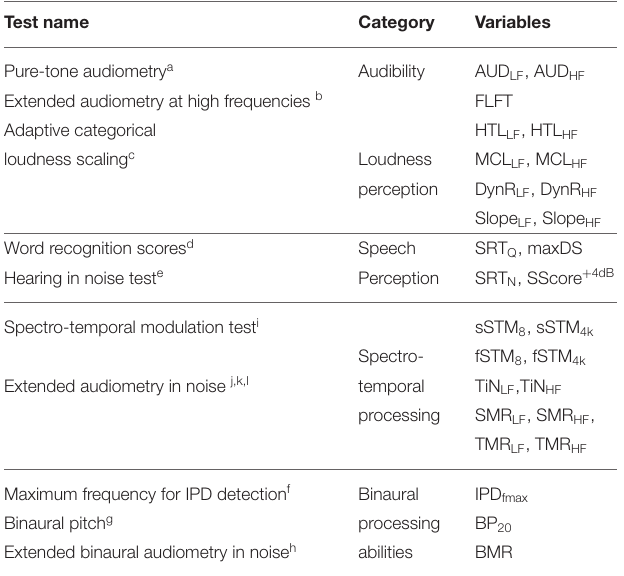
TABLE 1 | List of the tests included in the BEAR test battery and their corresponding auditory